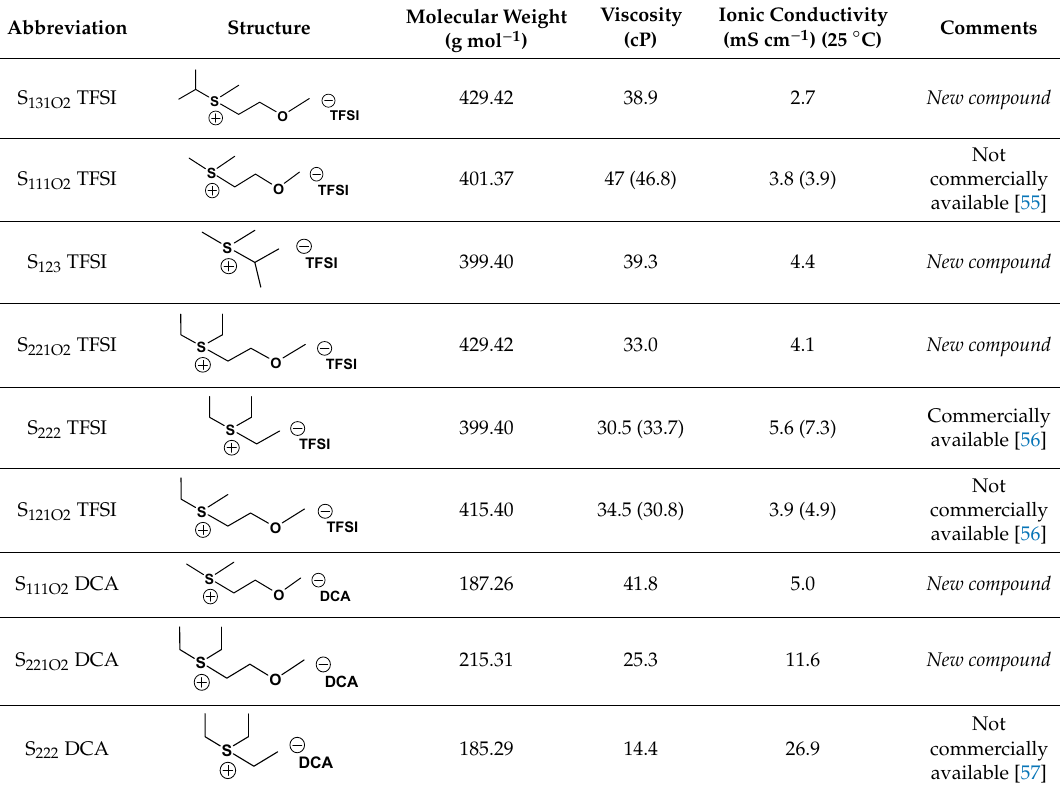
Table 6. Properties of Sulfonium-based ILs. Table 3. Properties of Sulfonium-based ILs. Table 3. Properties of Sulfonium-based ILs. Table 3. Properties of Sulfonium-based ILs. Table 3. Properties of Sulfonium-based ILs. Table 3. Properties of Sulfonium-based ILs. Table 3. Properties of Sulfonium-based ILs. Table 3. Properties of Sulfonium-based ILs. Table 3. Properties of Sulfonium-based ILs. Table 3. Properties of Sulfonium-based